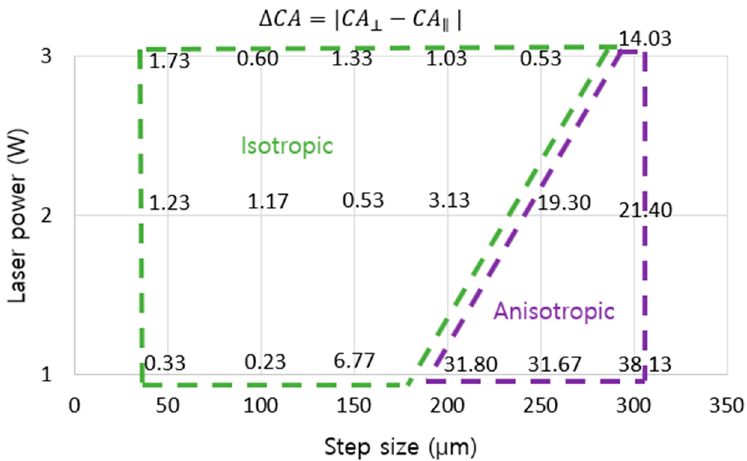
Figure 11. Effect of line-patterned microstructure on the wetting transition from the isotropic state to the anisotropic state.